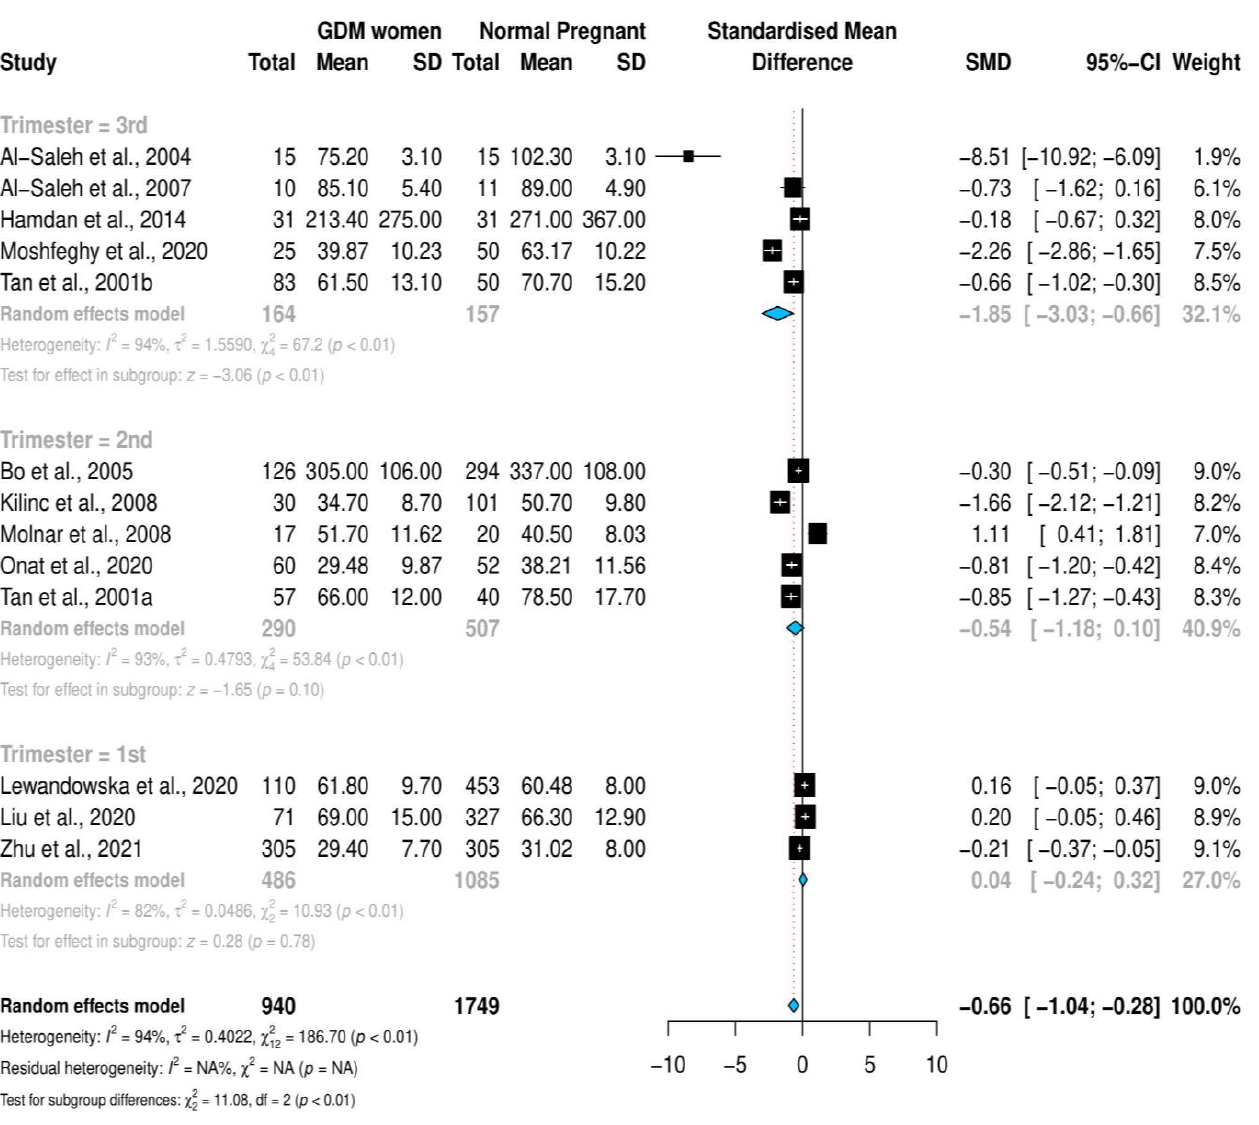
Figure 3. Forest plot of the association between selenium SMD levels and gestational diabetes mellitus; stratified meta-analysis according to trimester at which selenium was measured [20–26,29,31,38,43,44]. In the meta-regression analysis, none of the investigated factors—geographic location, trimester of selenium quantification, World Bank economic ranking, methods of selenium quantification, study design, study quality score, publication year and study sample size— showed any evidence of a relation with the overall estimate (Table